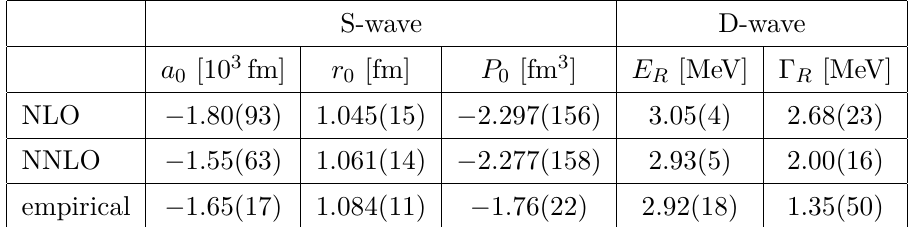
Table 1 . S-wave: the ERE parameters a 0 , r 0 and P 0 at NLO and NNLO. D-wave: the resonance parameters E and Γ at NLO and NNLO. The empirical values from ref. [47] are also R R